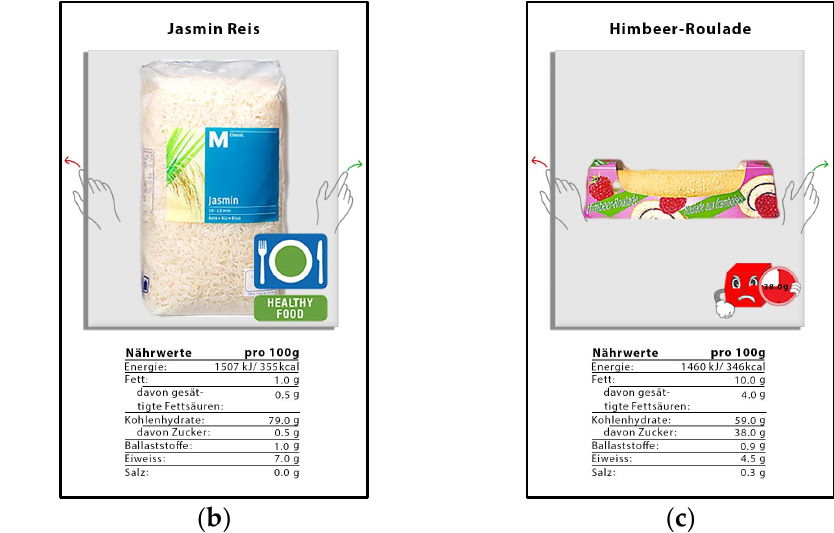
Figure 2. Examples of some selected conditions of the shopping task: ( a ) without label, ( b ) with the HFL, and ( c ) with the comic label.